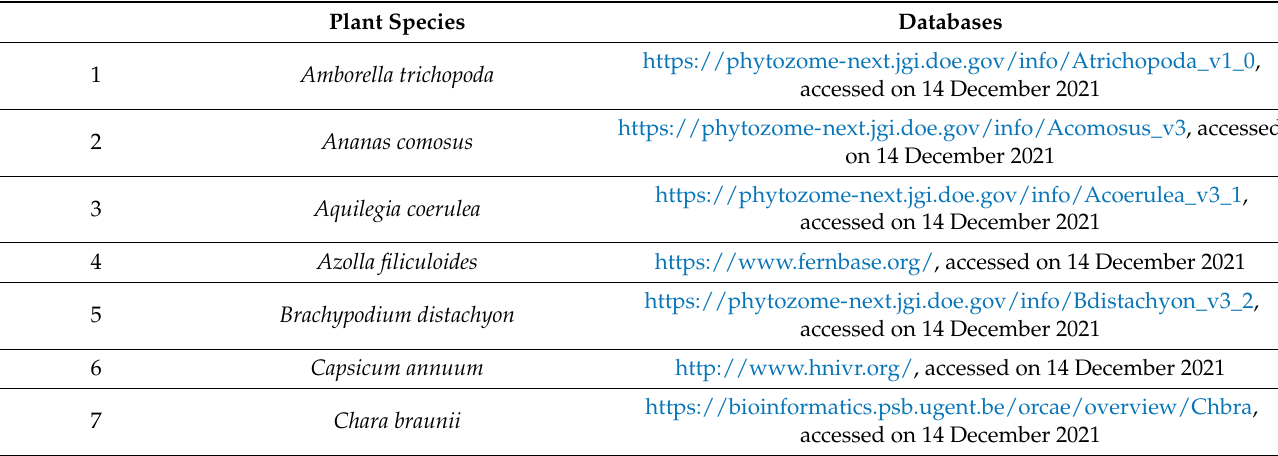
Table 1. The databases for the different plant species used in this study. Plant